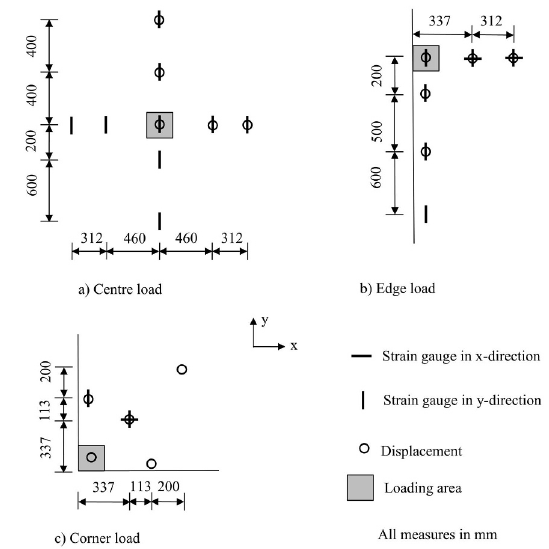
Figure 6. Location points for